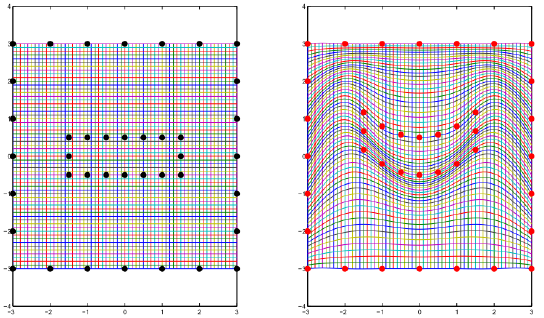
Figure 2. Mesh deformation driven by control points (Ref: